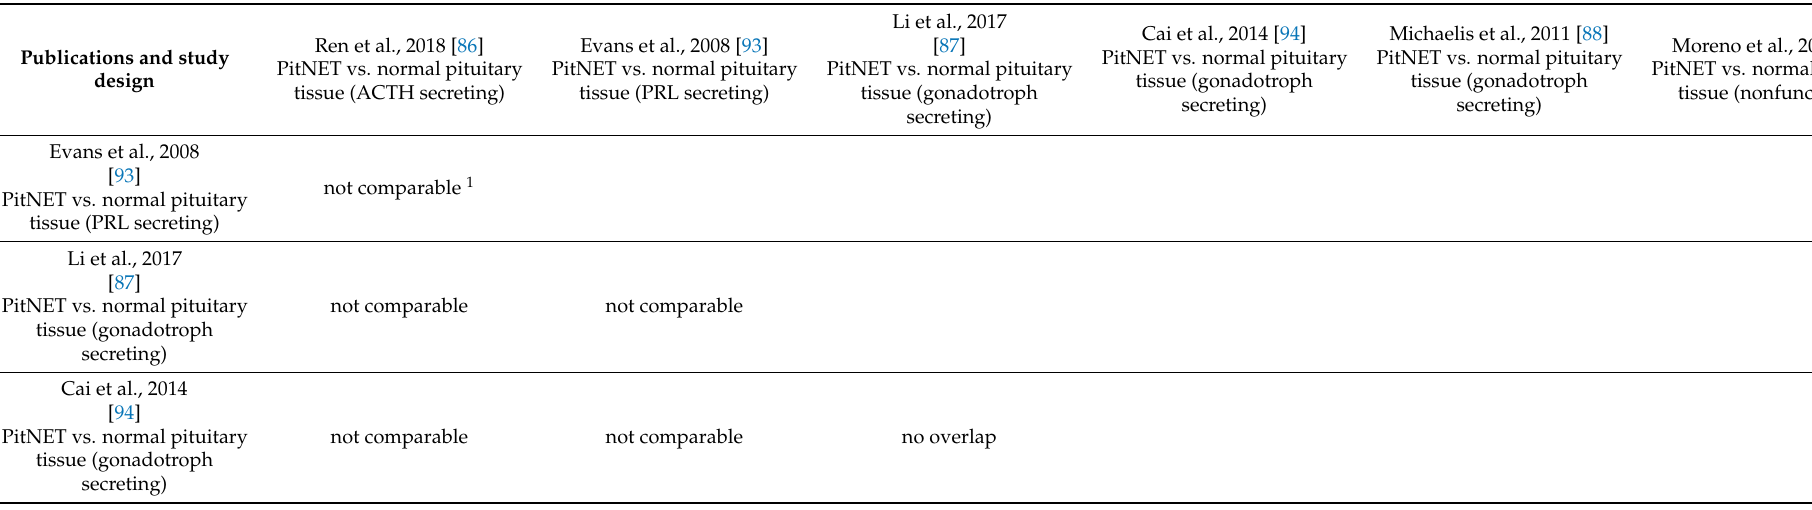
Table 2. Studies with overlapping candidate factors found in PitNETs compared to normal pituitary